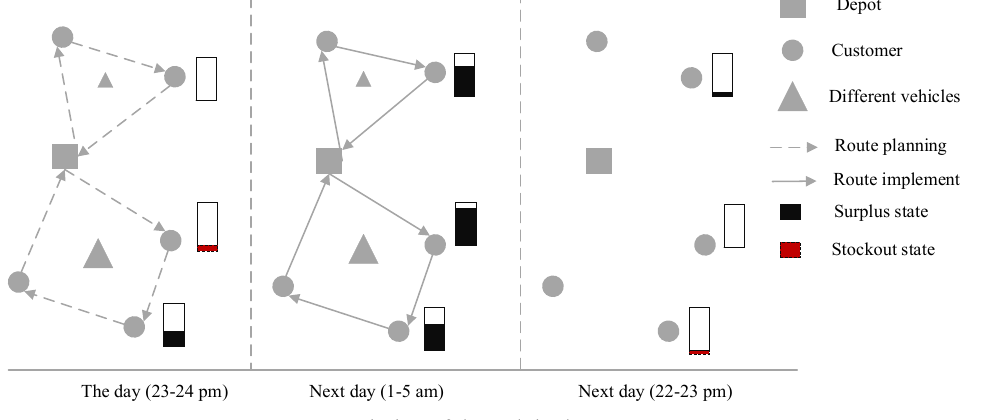
Fig. 1. Timing of the task in the